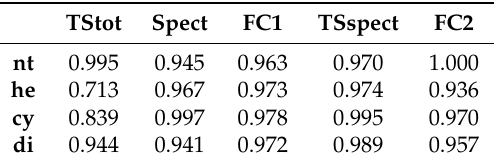
Table A8. Best ANNs’ F 1 score for wideband excitation (52kHz to 48kHz); grouped by shapes. Compare also Figure 10b. TStot